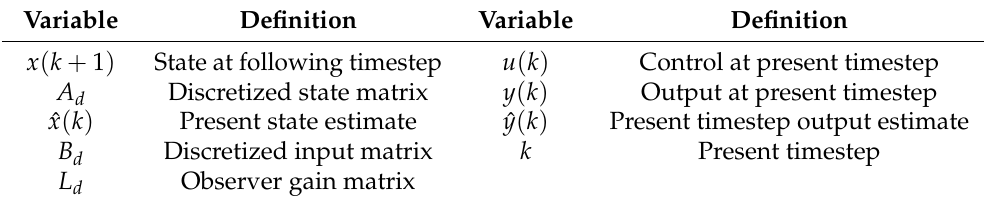
Table 3. Definitions of proximal variables for Section